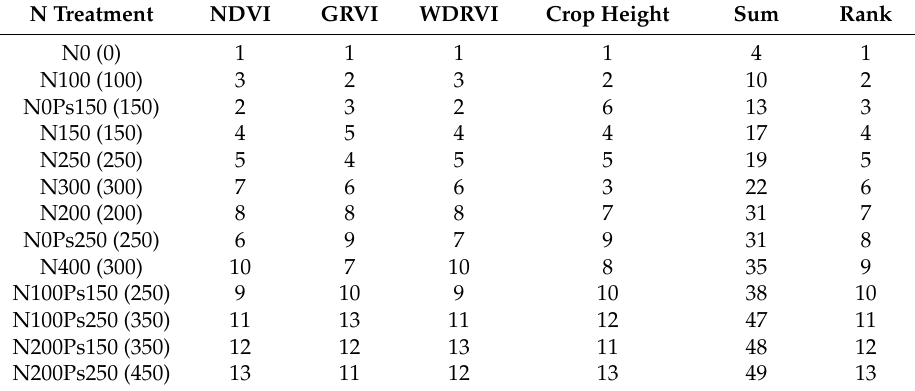
Table 2. Nitrogen fertilization treatments ordered by the mean values for each vegetation index and crop height at stage V12. The values are ordered from 1 to 13 (1 = lowest vegetation index and 13 = highest vegetation index). The treatments are ordered according to the “Rank” column, which orders the sum of the ranks. The total amount of N (kg · ha − 1 ) applied up to vegetation stage V12 is given in